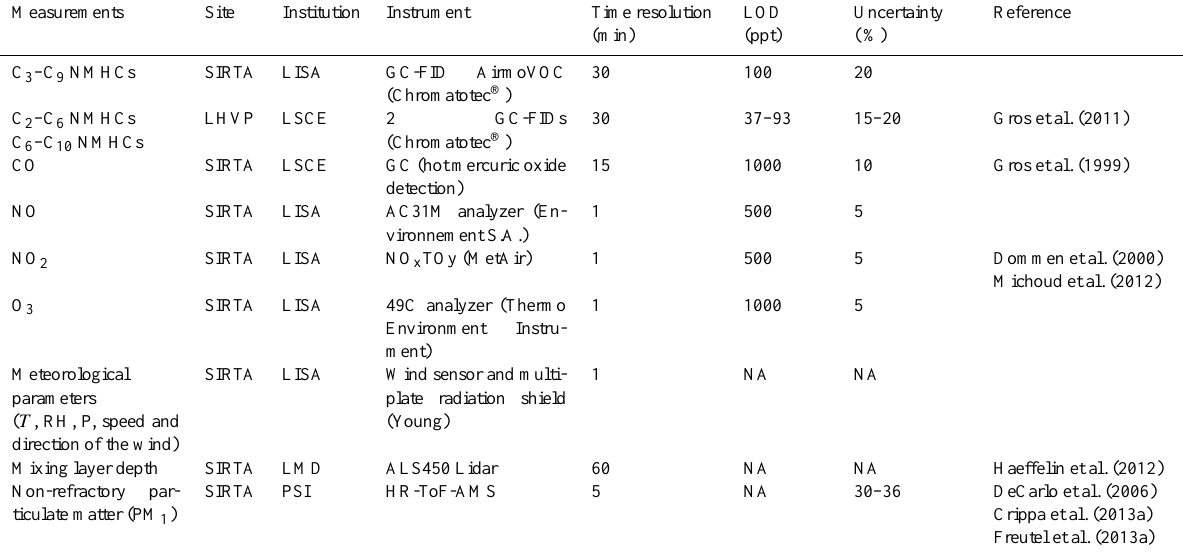
Table 2. Online measurements of organic carbon and ancillary data during MEGAPOLI at SIRTA and LHVP.